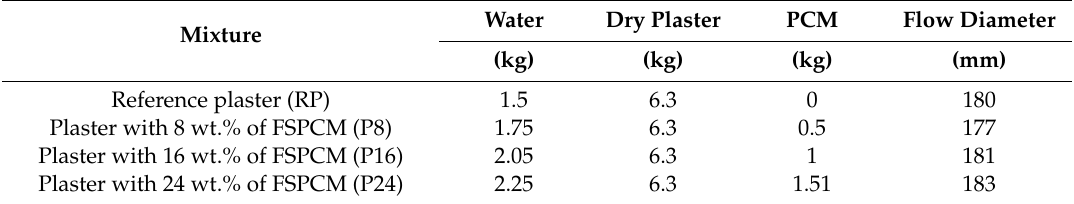
Figure 1. Particle size distribution. Table 1. Composition of the studied